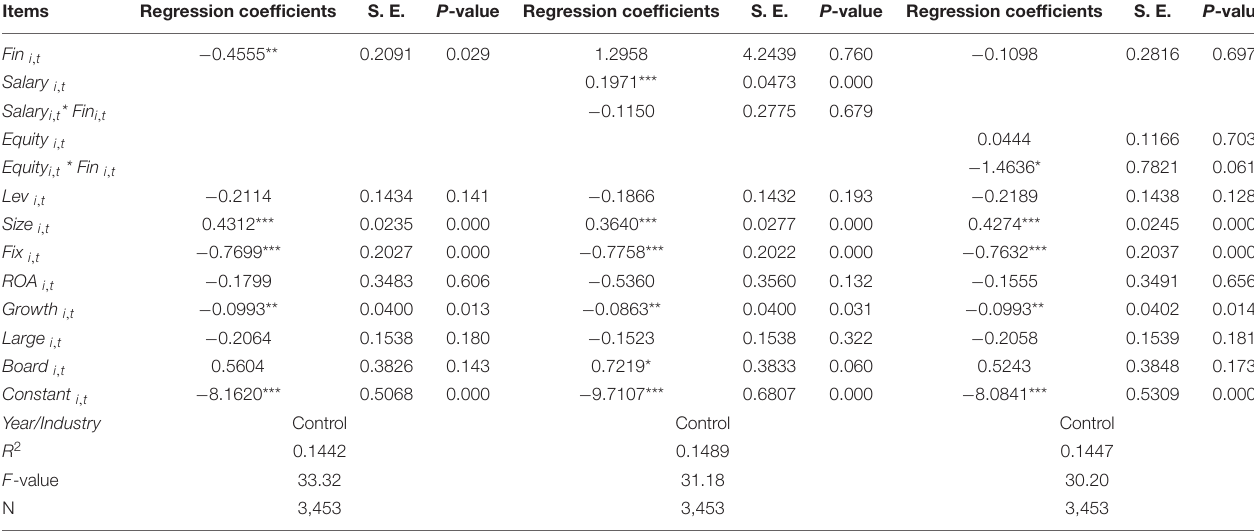
TABLE 11 | Distinguishing dependence of innovation (high-tech enterprise).